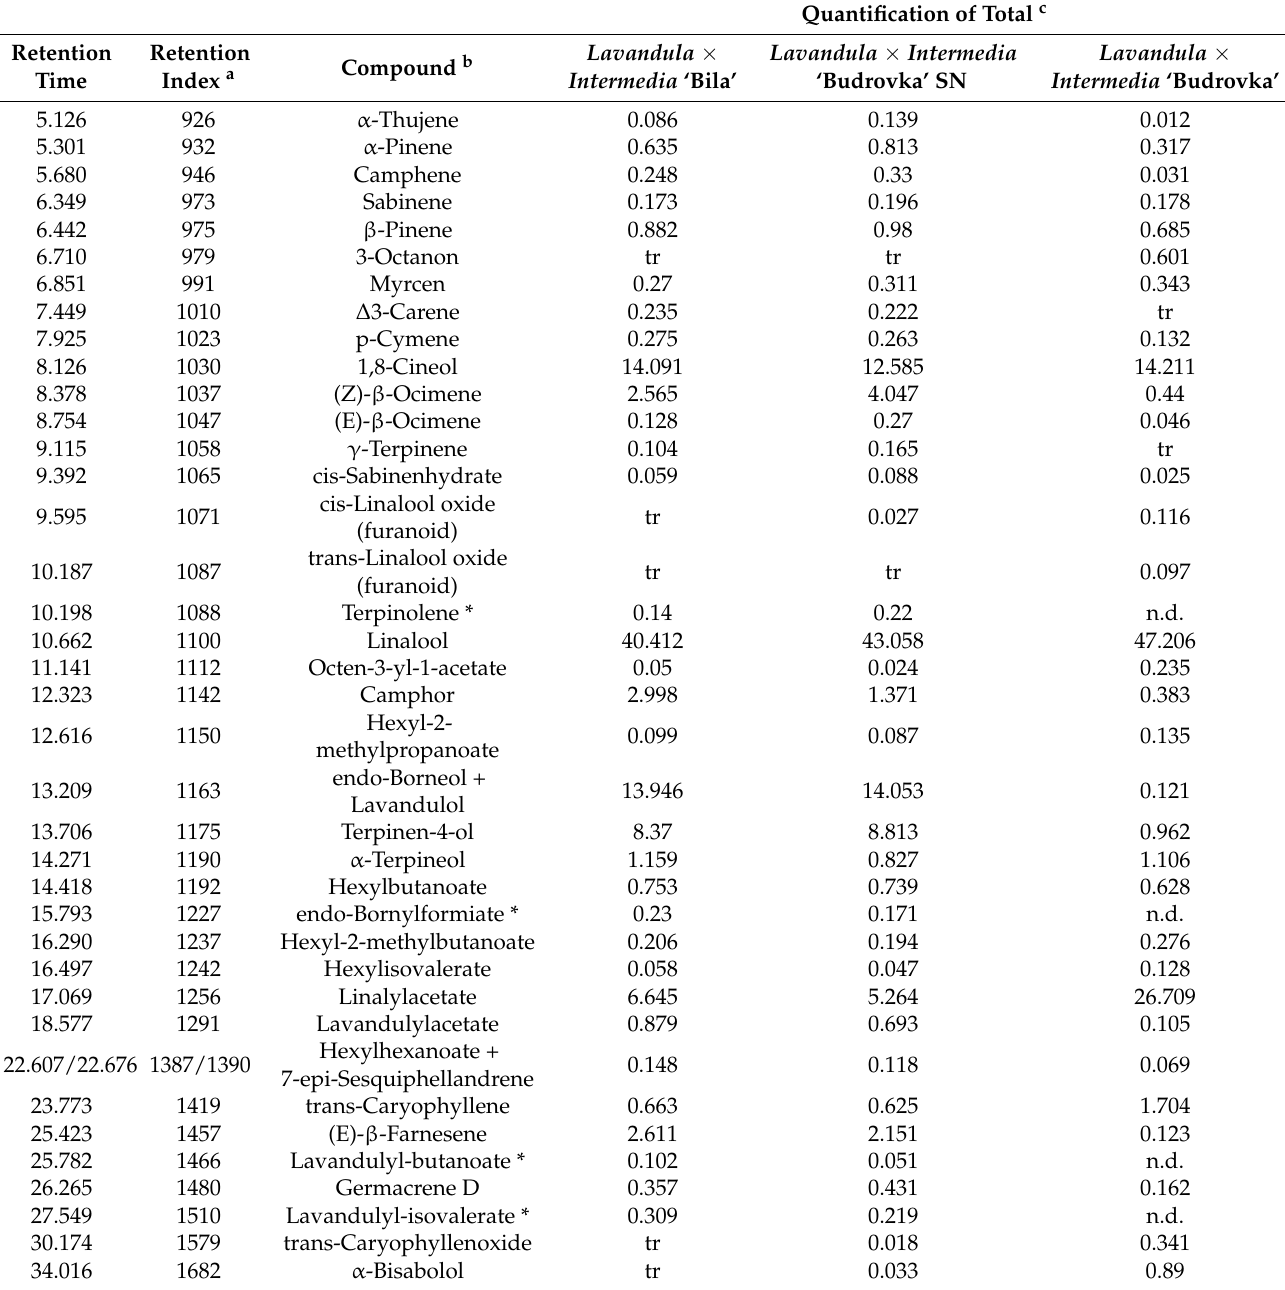
Table 2. Identification of the main components of the lavandin